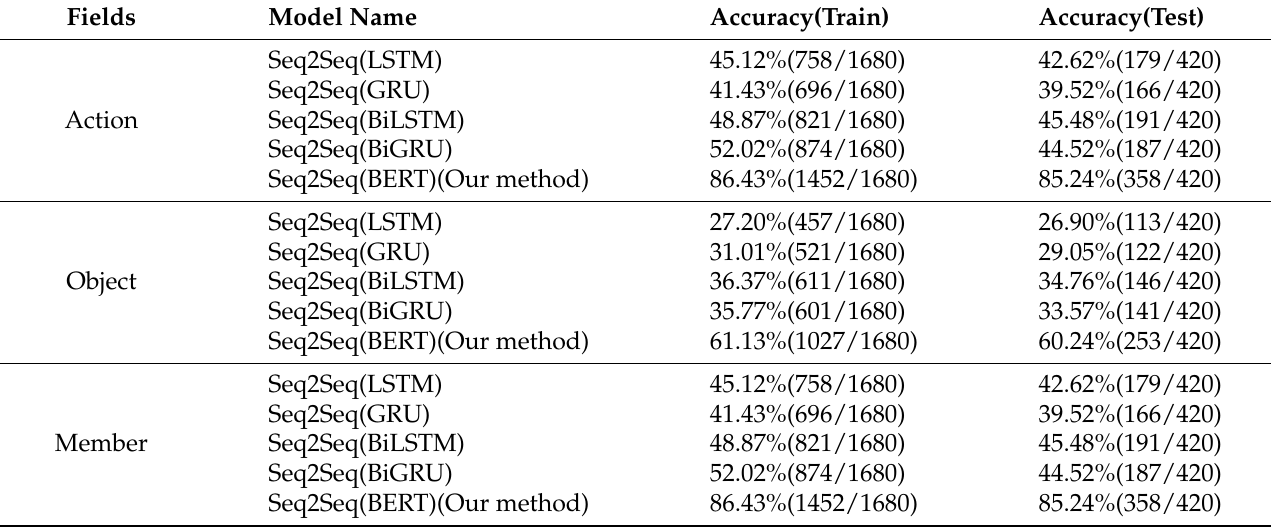
Table 8. Segments Generation Accuracy.